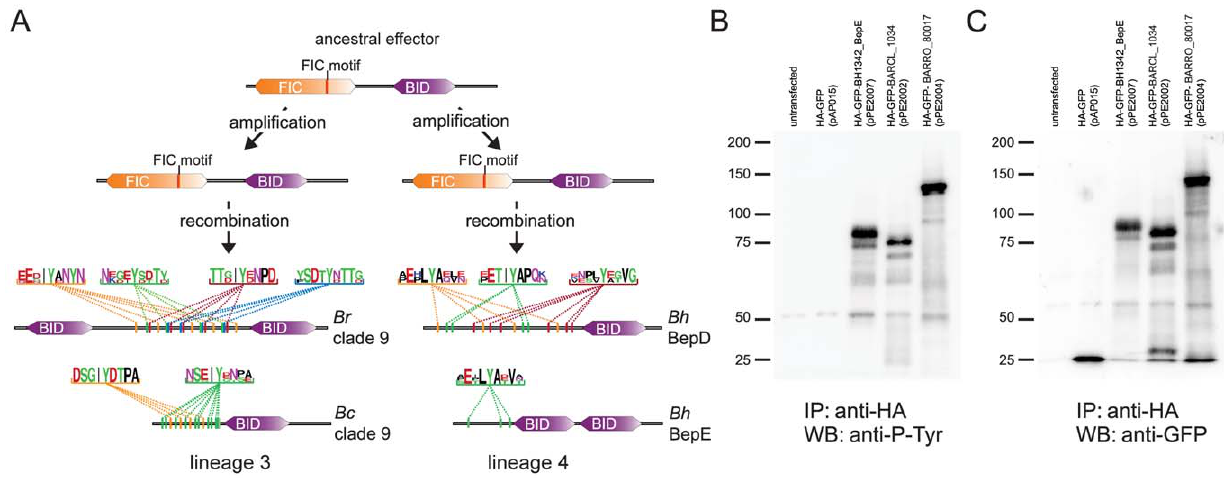
Figure 5. Parallel evolution of Bartonella effector proteins harboring tandem-repeated tyrosine motifs phosphorylated in host cells. (A) The lineage-specific amplification of effector proteins harboring the ancestral domain structure was followed by secondary recombination events in both lineages. This resulted in the independent emergence of Beps with a derived domain structure (see also Figure S5). In silico predictions for tyrosine-phosphorylation motifs consistently detected high numbers of tandem-repeated phosphorylation sites in independently derived Beps of both lineages (here shown for two Beps of Bep clade 9 [BARRO_80017 of Br and BARCL_1034 of Bc ] from lineage 3 and BepD and BepE of Bh from lineage 4). The depicted motifs were identified with NetPhos2.0 with a score $ 0.8 (for predictions of all motifs in lineage 3 see Table S4). The consensus sequence of tandem-repeated motifs (color-coded) is shown for each of the four Beps by WebLogos (http://weblogo.berkeley.edu/logo. cgi). (B) and (C), Immunoprecipitation/Western blot analysis of Beps with predicted tyrosine-phosphorylation motifs ectopically expressed in HEK293T cells. Immunoprecipitations were performed with HA antibody-coated agarose beads. (B) Western blot analysis was performed with anti- phosphotyrosine antibody. (C) Western blot analysis was performed with anti-GFP antibody. The tested constructs correspond to the Beps of Bep clade 9 (BARCL_1034, 70.8 kDa, and BARRO_80017, 113.1 kDa) and BepE of B. henselae (BH13420, 81.4 kDa) shown in (A). HA-GFP was used as a control (28.7